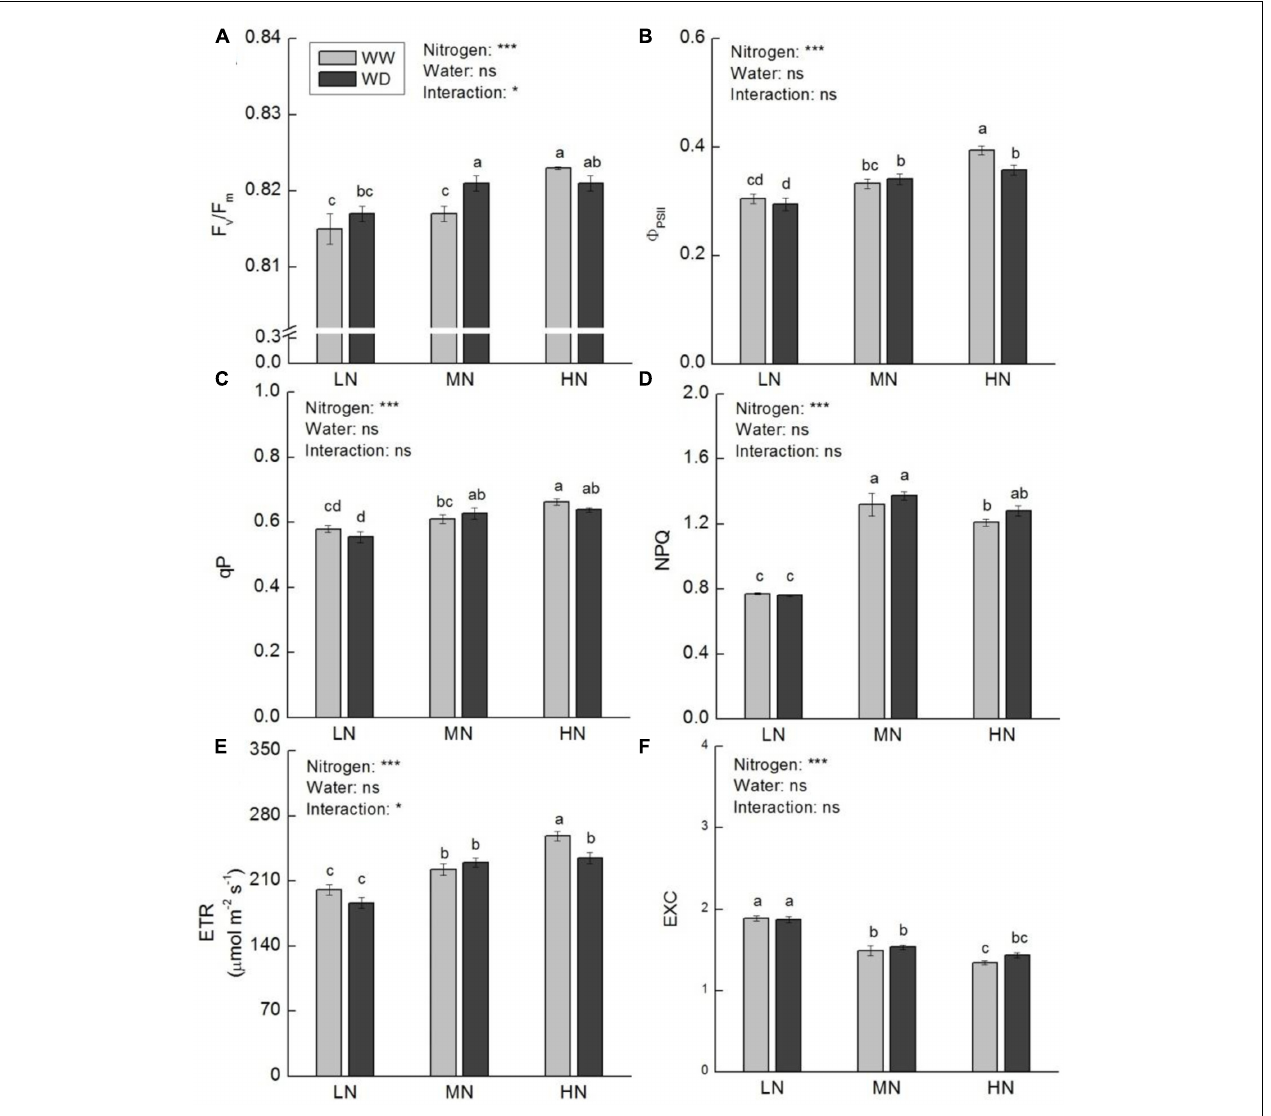
FIGURE 4 | Comparison in chlorophyll fluorescence parameters in rice plants grown udner different nitrogen and water conditions. (A) Maximum quantum yield of PSII photochemistry. (B) Effective quantum yield of PSII photochemistry. (C) Photochemical quenching coefficient. (D) Non-photochemical quenching coefficient. (E) Electron transport rate at PSII level. (F) Relative excessive energy at PSII level. Data refers to mean ± SE ( n = 4). P -values of the two-way ANOVAs of nitrogen, water, and their interaction are indicated: ns, not significant; ∗ P < 0.05; ∗∗ P < 0.01; ∗∗∗ P < 0.001. Bars with the same letter are not significantly different by LSD test. WD, water deficit; WW,